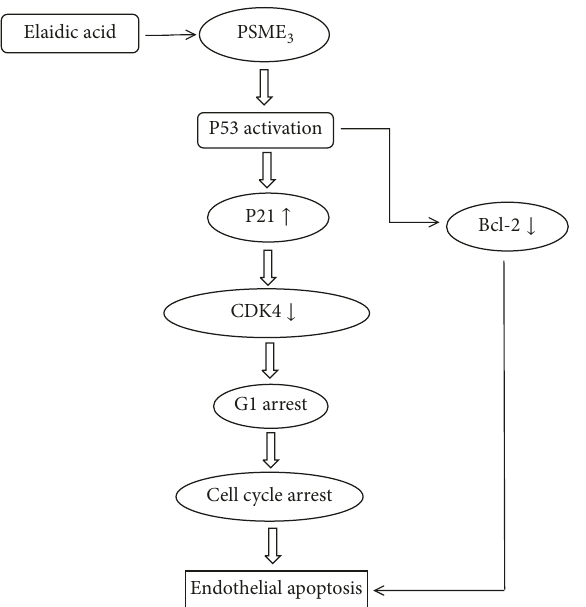
Figure 8: Schematic diagram showing signaling pathway of elaidic acid treatment in endothelial